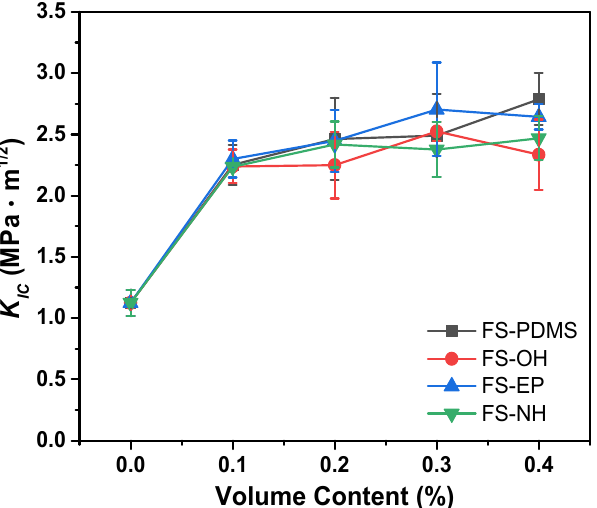
Figure 7. Mode I fracture toughness ( K IC ) of epoxy adhesives with different silica nanoparticles and contents.